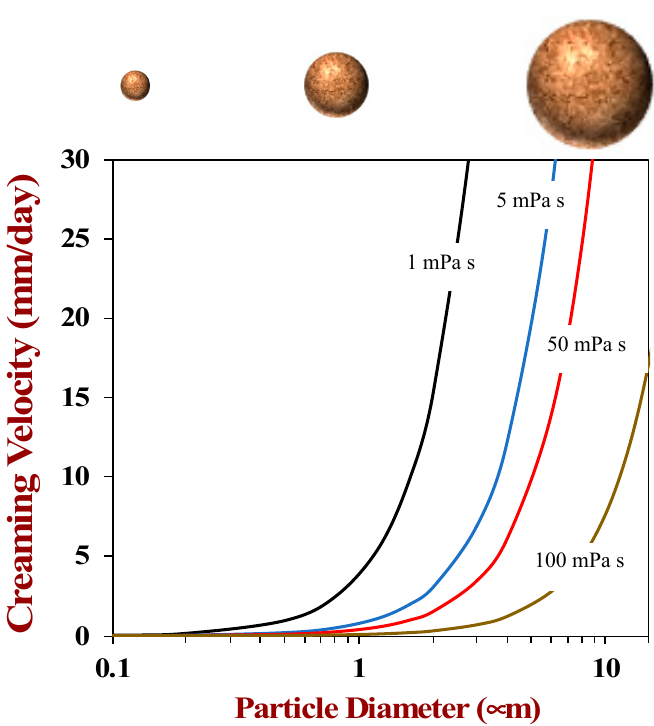
Figure 5. The creaming stability of plant-based milks depends on the size of the particulate matter they contain. The theoretical predictions were made by the author using Stoke’ law for oil droplets of different sizes suspended in aqueous solutions with different viscosities.